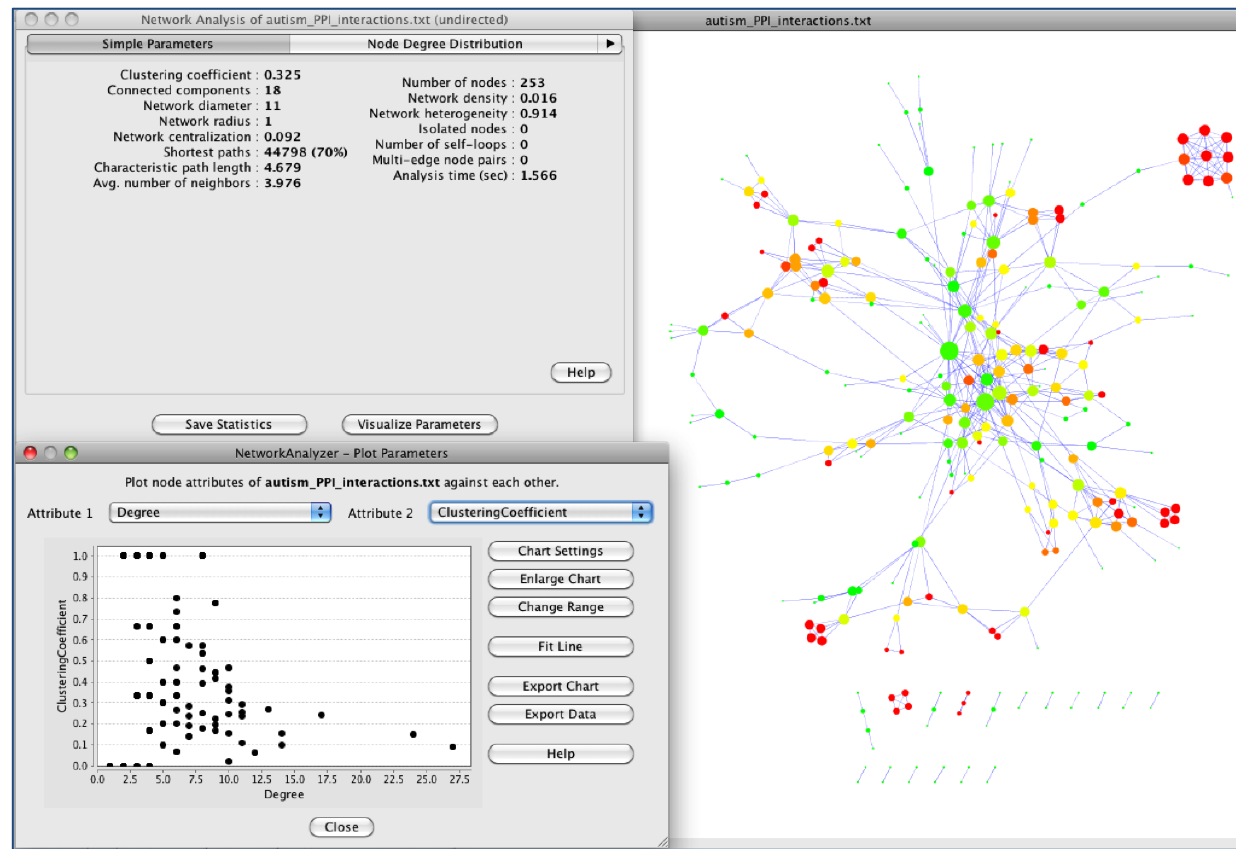
Figure 2. Topological analysis of autism protein-protein interaction (PPI) network using Cytoscape [8]. Genes associated with autism have been downloaded from Genotator (see section 4.2.), and PPI interactions have been obtained from String [7]. In autism PPI network, the large size of nodes represents a high degree, while dark colors mean values of clustering